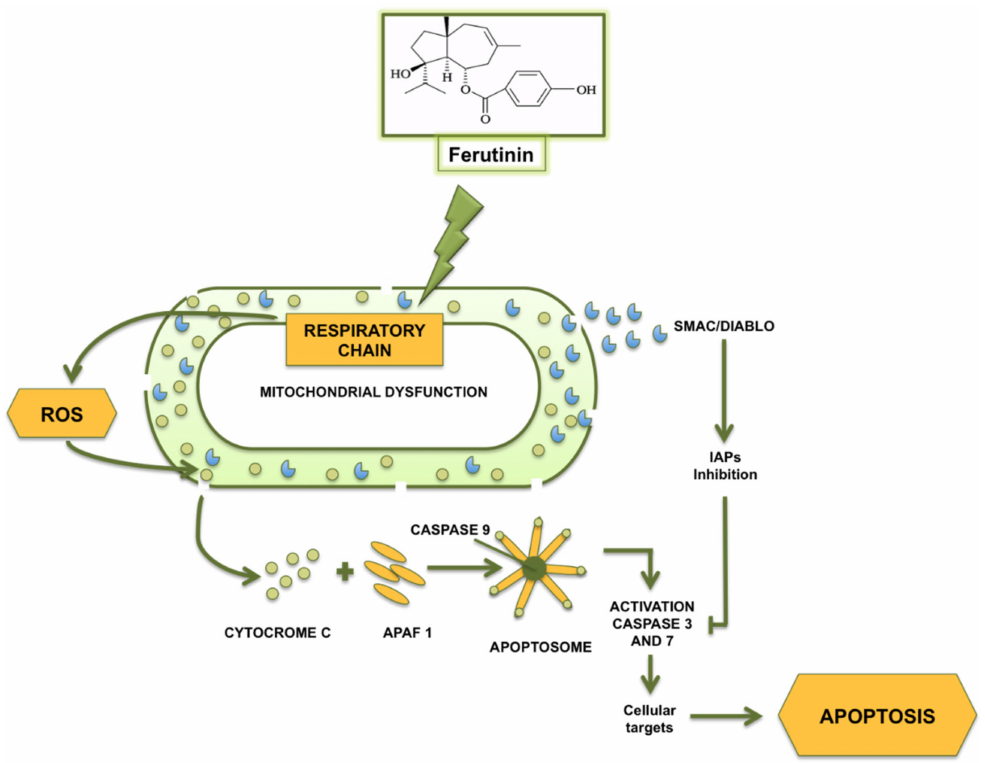
Figure 4. Ferutinin-induced mitochondrial dysfunction: key role of ferutinin action on respiratory chain complex I and